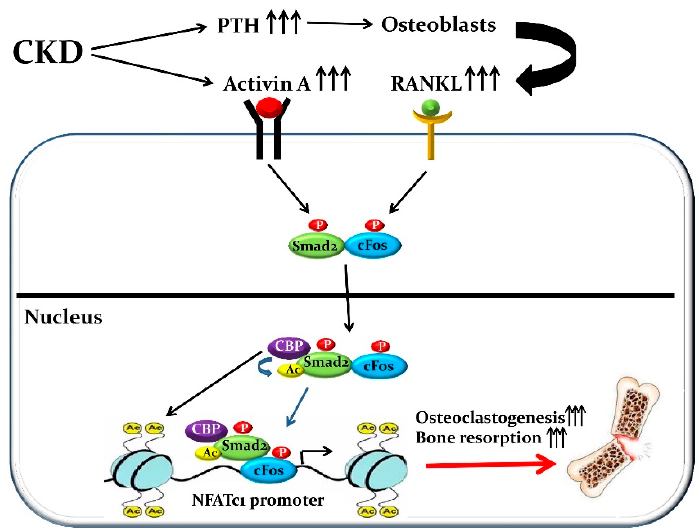
Figure 2. Activation of activin A signaling stimulates RANKL-induced osteoclast development and function in CKD. The nuclear translocation of c-Fos and the DNA binding of activated-c-Fos to the NFATc1 promoter is induced by RANKL alone without Smad2 for osteoclast formation and function. In contrast, the combination of RANKL and activin A treatment induces a complex composed of activated-c-Fos and activated-Smad2 and stimulates the nuclear translocation of the complex so that the DNA binding of activated-c-Fos to the NFATc1 promoter is strongly boosted by acetylated-Smad2 caused by CBP.